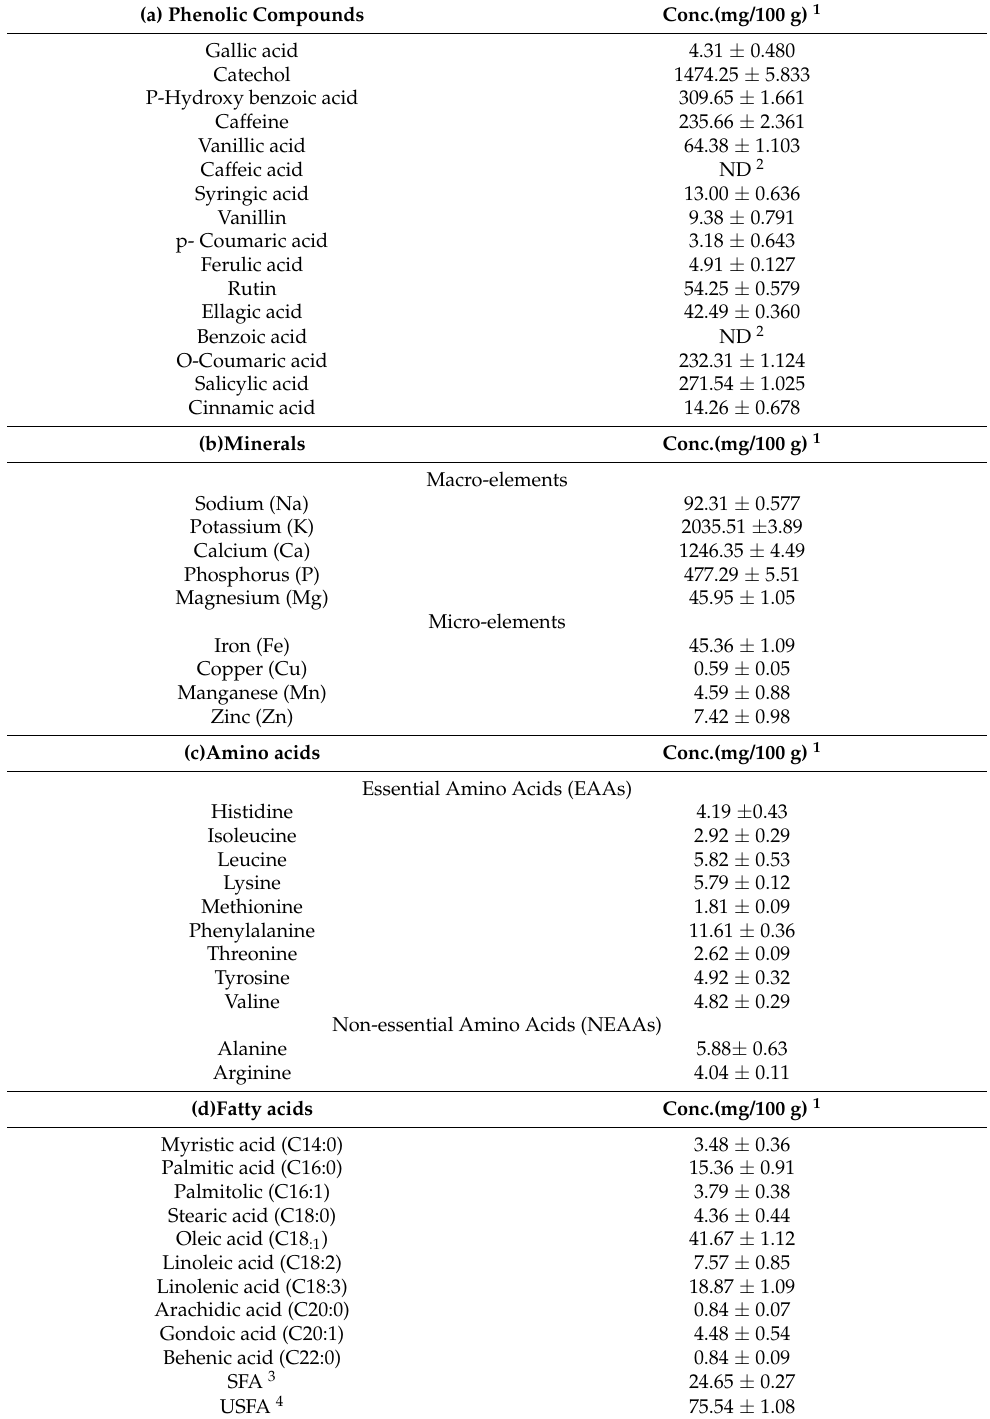
Table 1. ( a ) Phenolic composition, ( b ) mineral (elemental) composition, ( c ) amino-acid profile and ( d ) fatty acid profile of Rosmarinus officinalis L.